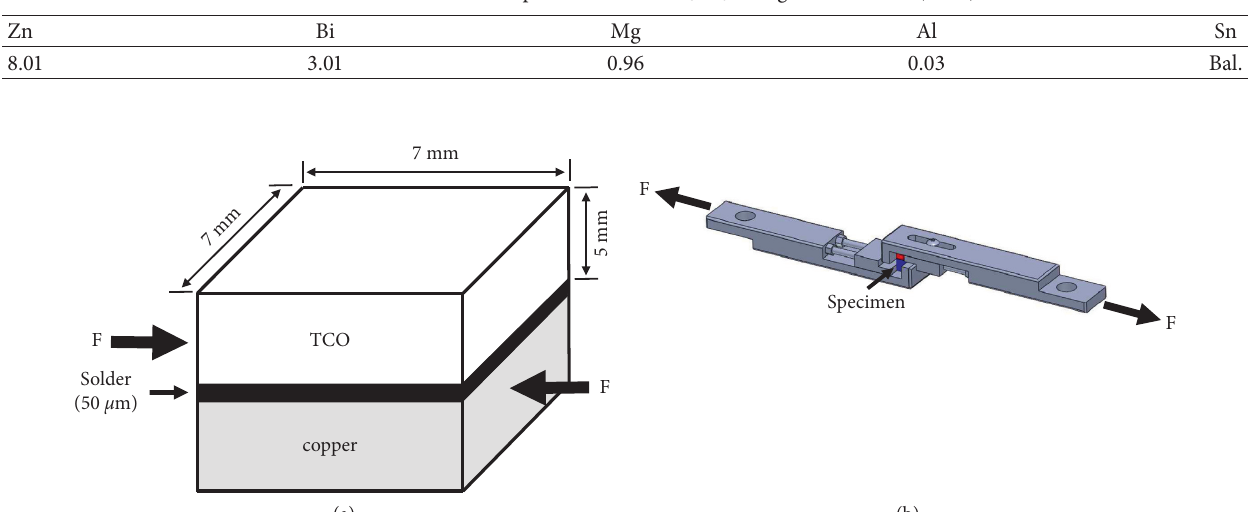
8 Zn 3 Bi 1 Mg active